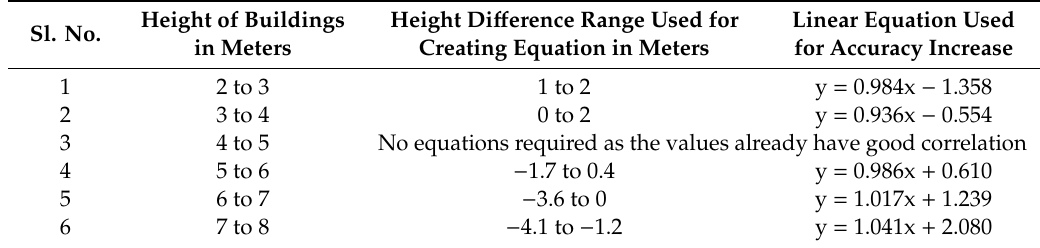
Table 2. Correlation values for different ranges and linear equation for accuracy enhancement (Nottingham) .